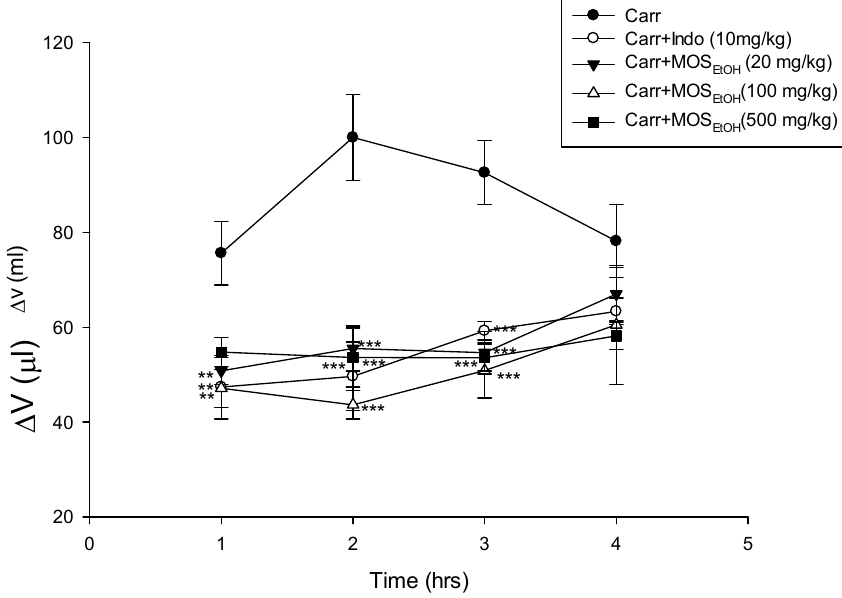
Figure 4. Inhibitory effects of MOS on carrageenan-induced mice paw inflammation. EtOH (20, 100 and 500 mg/kg) significantly reduced paw volume. Treatment with MOS EtOH Delta volume ( Δ V) represents the degree of swelling of carrageenan-treated paw. Each value represents the mean ± SEM ( n = 10). * p < 0.05 ** p < 0.01, *** p < 0.001 as compared with the carrageenan-treated only group.